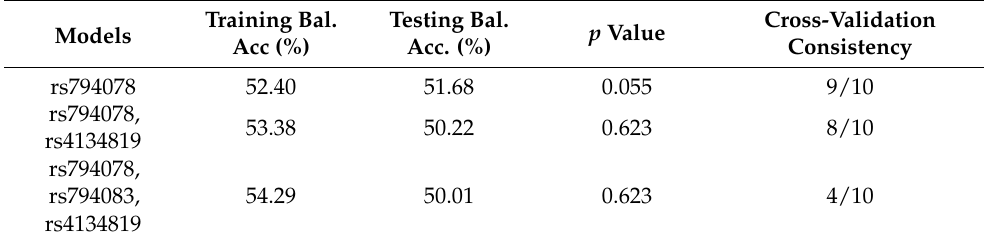
Table 3. Summary of multifactor dimensionality reduction (MDR) gene–gene interaction results for XAB2 gene.